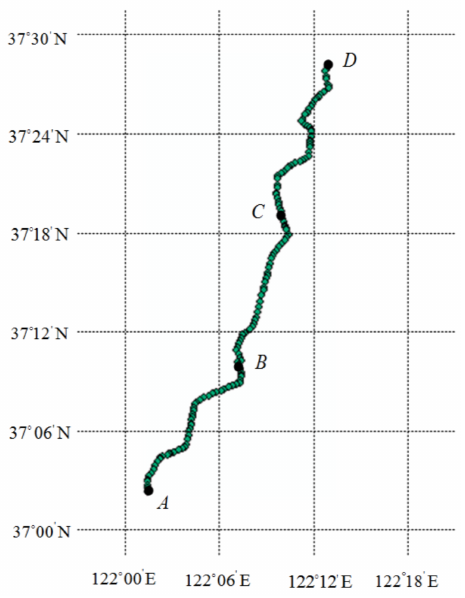
Figure 2. Geographic diagram of the transmission